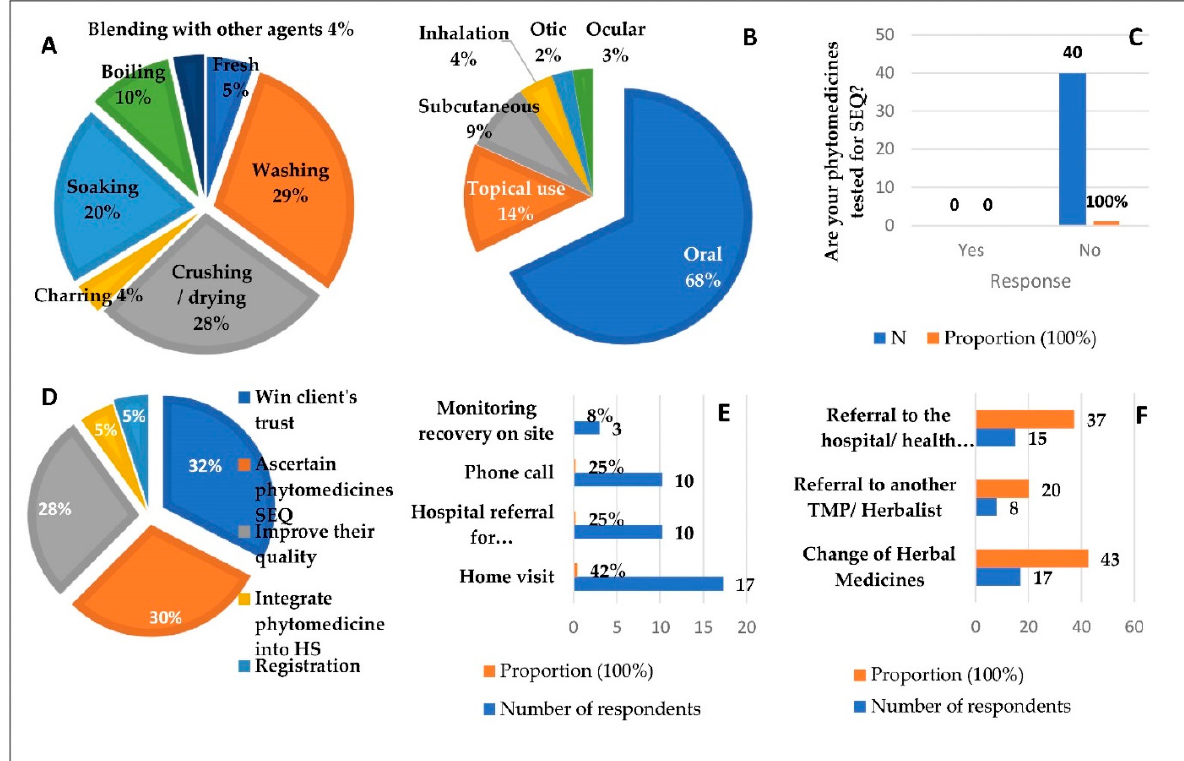
Figure 4. ( A ) Methods of plant material preparation; ( B ) modes of administration; ( C ) participant’s response if their phytomedicines were tested for SEQ; ( D ) advantages of testing phytomedicines for